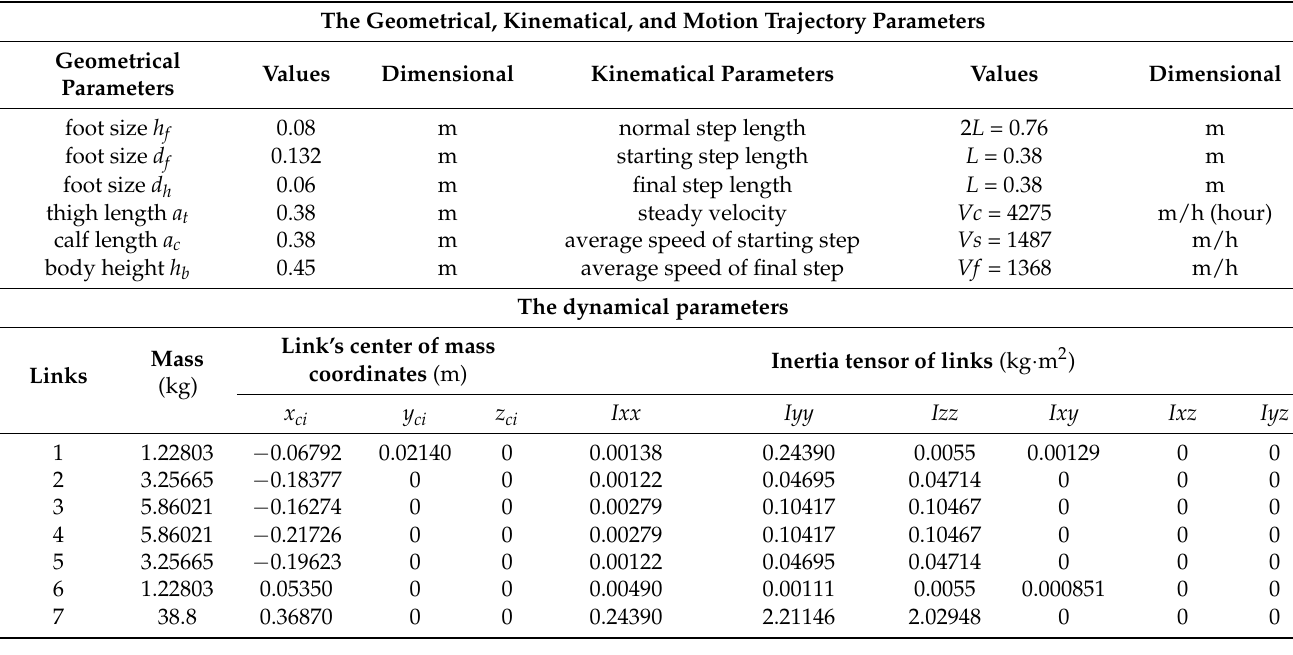
Table 1. The kinematic, dynamic, and motion trajectory parameters of the proposed robot model.